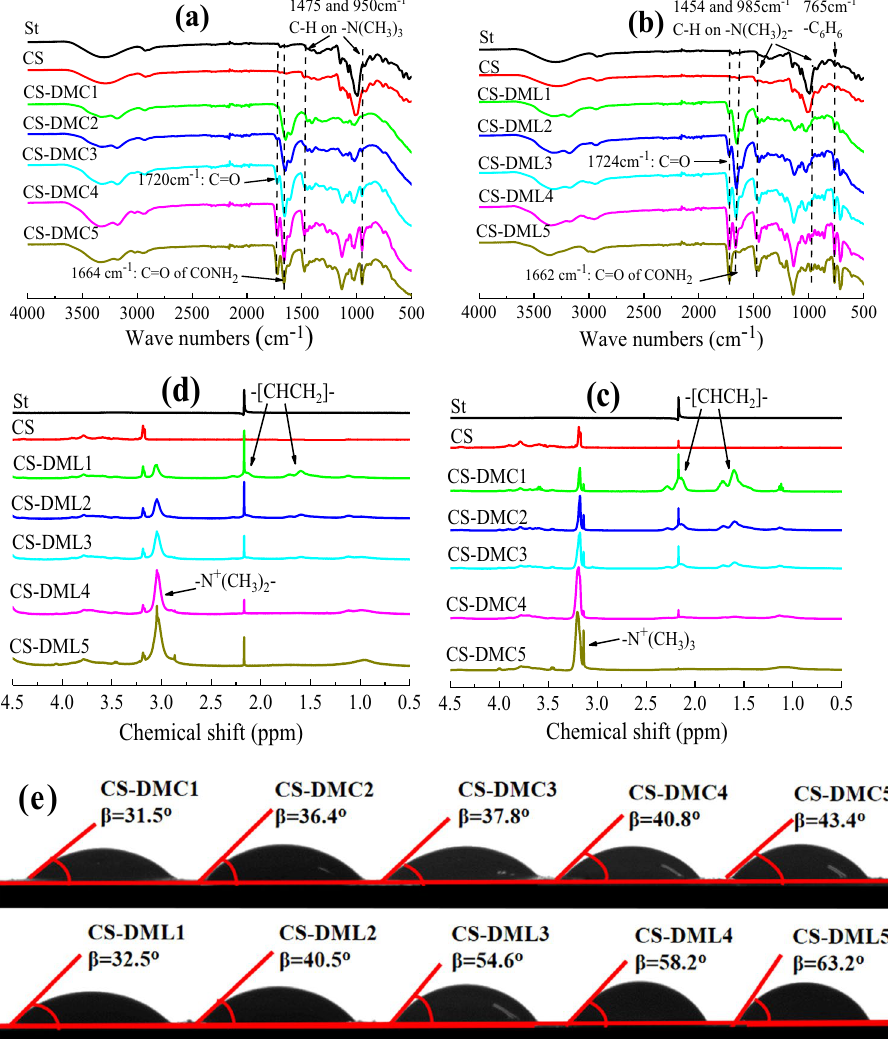
Figure 1. ( a , b ) FTIR, ( c , d ) 1 H NMR spectra, and ( e ) contact angle of Starch (St), CS, CS-DMCs and CS-DMLs samples.